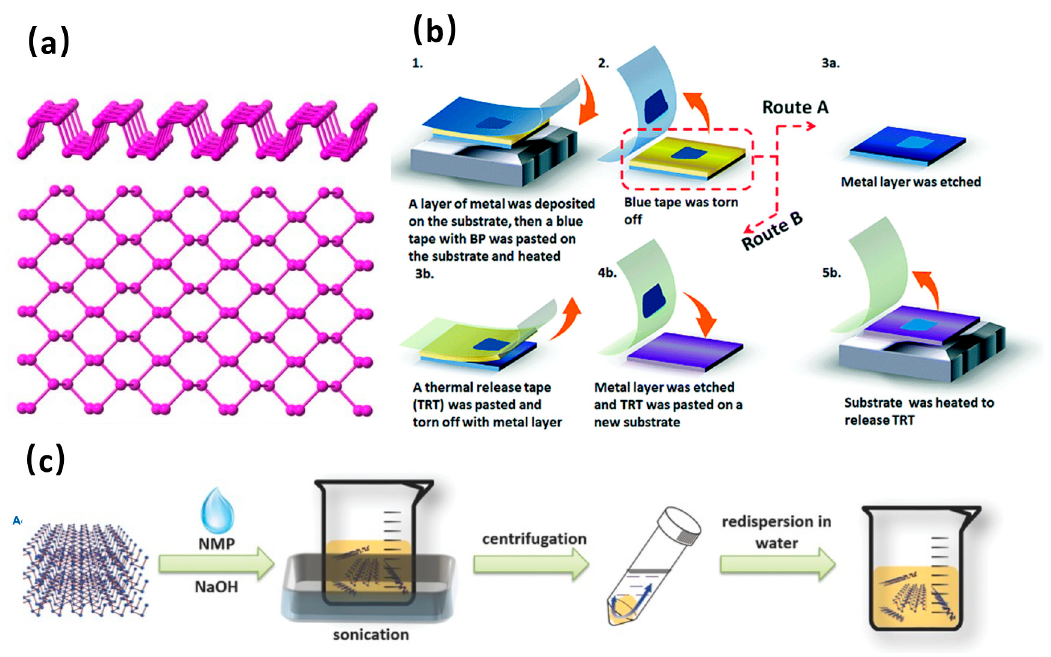
Figure 5. ( a ) Structure of phosphorene (side and top view) [91]. ( b ) Schematic diagram of the metal-assisted exfoliation process for few-layer black phosphorus [92]. Reprinted with permission from ref [92]. Copyright 2018, The Royal Society of Chemistry. ( c ) Schematic diagram of liquid-phase exfoliation process (basic-N-methyl-2-pyrrolidone(NMP)-exfoliated) phosphorene [93]. Reprinted with permission from ref [93]. Copyright 2015, WILEY-VCH Verlag GmbH and Co. KGaA, Weinheim.